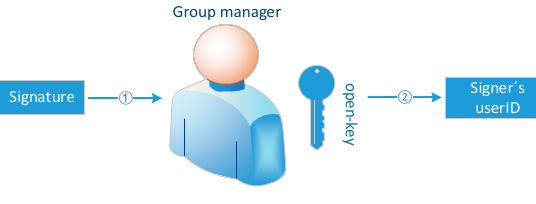
Figure 7. Traditional accountability procedure.